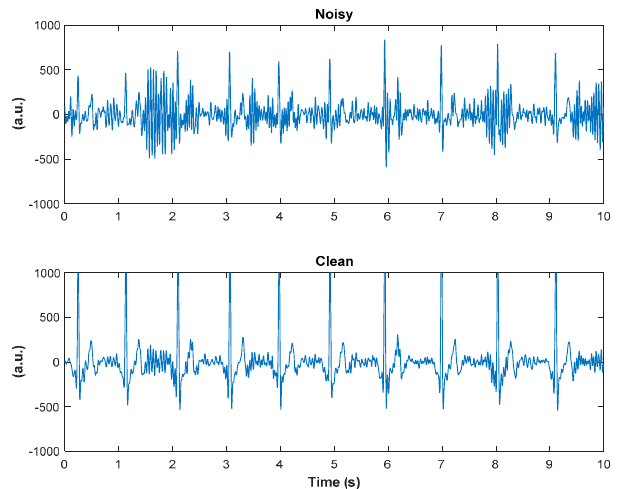
Figure 2. An illustrative example of a 10-s sequence from a noisy channel, denoted as noisy (top panel) and the corresponding sequence from a clean channel, denoted as clean (bottom panel), of armband